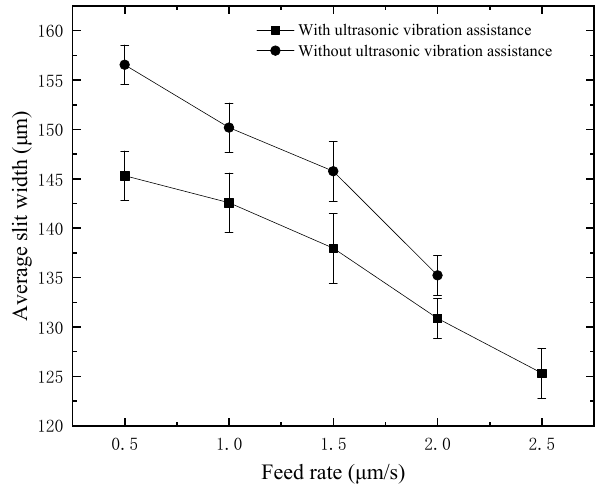
Figure 13. Slit width at different pulse frequencies.